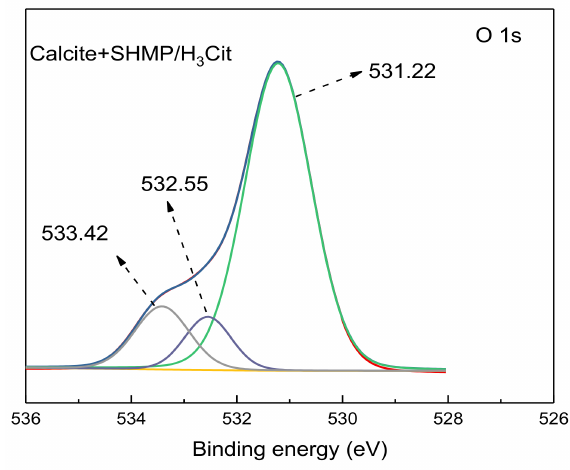
Figure 12. Fitting peaks of Ca 2p 3 / 2 on mineral surfaces.